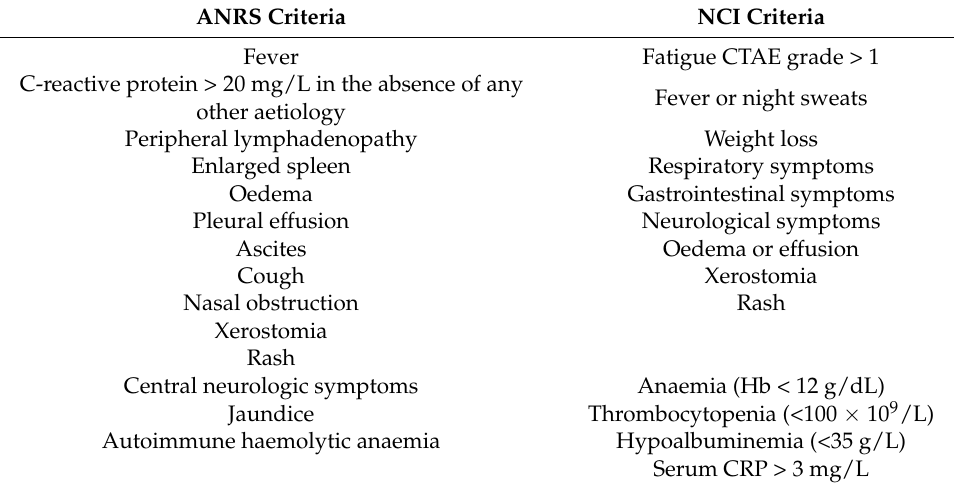
Table 3. Comparison of French ANRS (Agence Nationale de Recherche sur le SIDA) 117 CastlemaB trial group and the National Cancer Institute (NCI) criteria used to define a flare of KSHV-associated multicentric Castelman disease